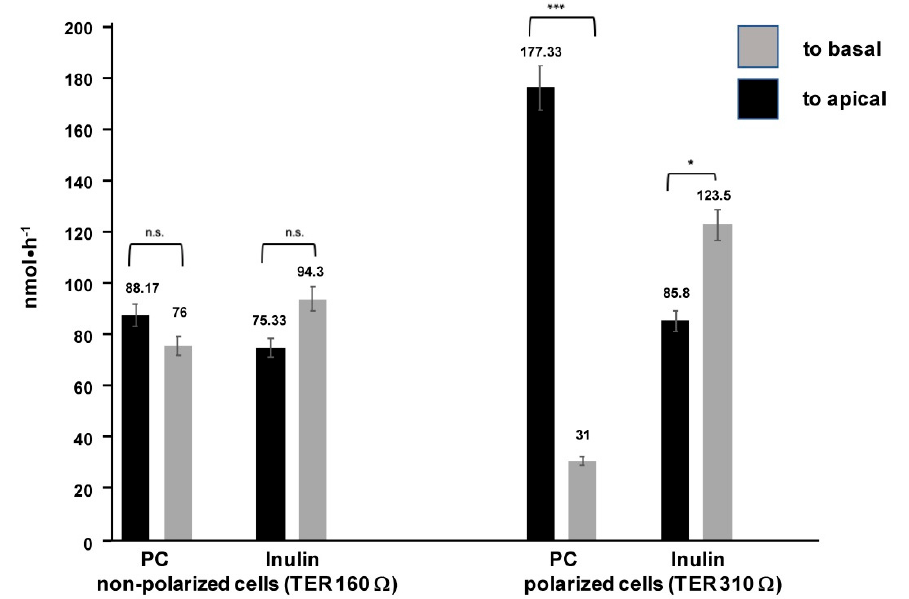
Figure 2. Apical vs. basal transport of phosphatidylcholine (PC) and inulin applied to a transwell culture system of non-polarized (three days cultured) and polarized (21 days cultured) Mz-ChA-1 cells. Means ± SD of n = 6; n.s. = not significant, * p < 0.05, *** p < 0.001. TER, transepithelial resistance. The intracellular accumulation was tested in non-polarized cells incubated with 100 μ M for 1 h and accounted for <5% of the incubated PC, whether it was provided together with TC or albumin. Only when PC was provided with apolipoprotein B (ApoB) an uptake rate of 12.84 ± 5 nmol·mg protein -1 ·h -1 was observed indicative of lipoprotein-mediated endocytosis of PC. In comparison, 1 h uptake rates for radiolabeled TC and oleate, the later complexed with TC or albumin, were significantly higher ( p < 0.01) (Figure 3).